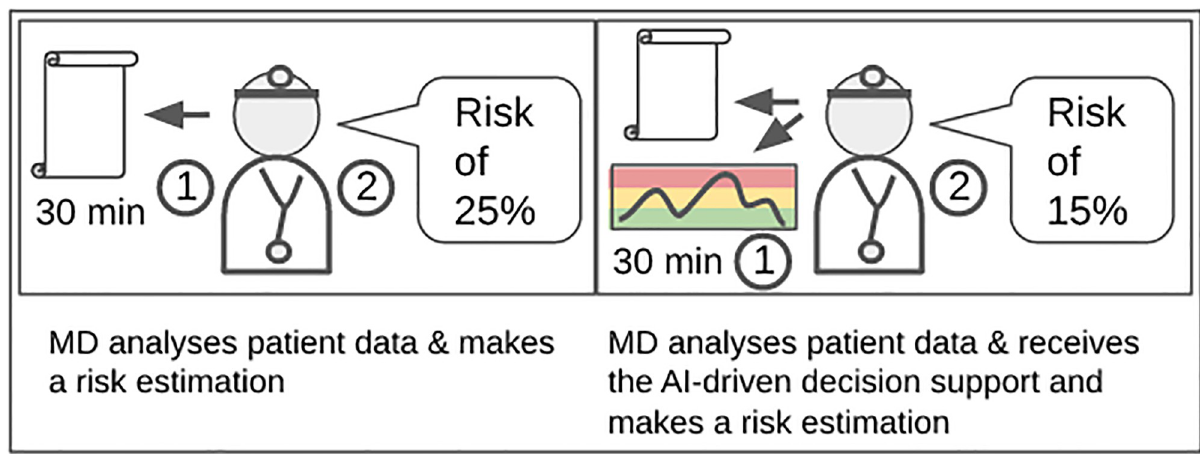
Fig 3. Overview of the two parts of the reader study. On the left, the setup with medical doctors (MD) alone. The MD has up to 30 minutes to 1) study the patient at a given date in his/her life and then 2) make a risk estimation for infection for the next 90 days. The right-hand side depicts the setup in which 1) the MD also receives the patient data and the risk estimation of the decision support system. After analyzing both for up to 30 minutes, the physician 2) makes a risk estimation.